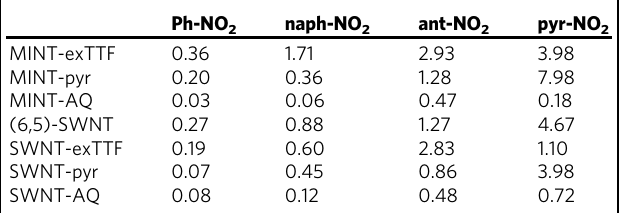
Table 1 First-order kinetic constants ( k values in s − 1 × 10 − 3 ) as obtained from the fi ts shown in the insets of Fig.